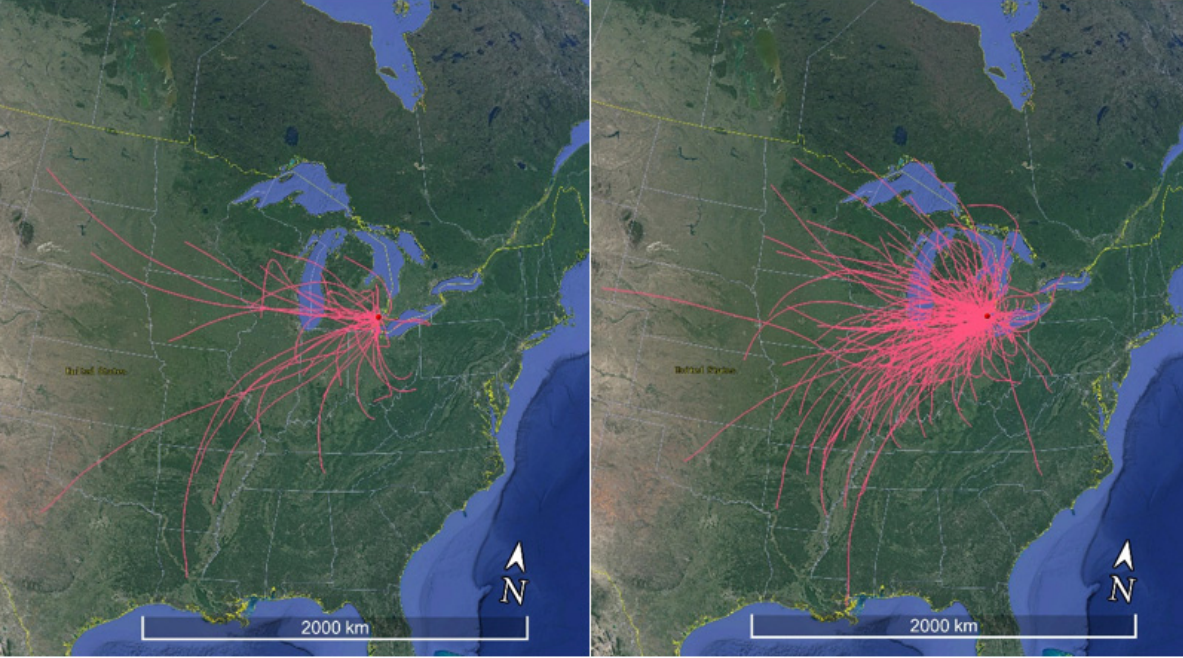
Figure 7. Back trajectories of AQHI = 5 days in warm season. The red dot is Windsor.